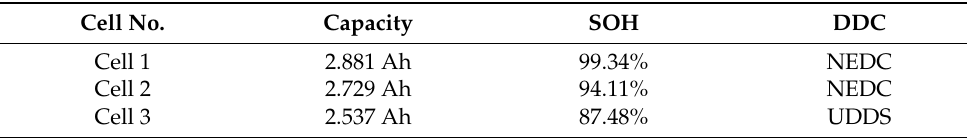
Table 1. Cells used in the